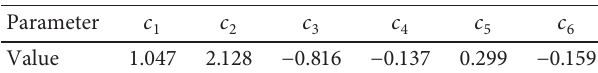
Figure 6: Relationship between dimensionless critical moment and dimensionless torsional stiffness. Table 1: The values of parameters of critical moment with torsional (equation (15)). bracing 􏽥 M cr